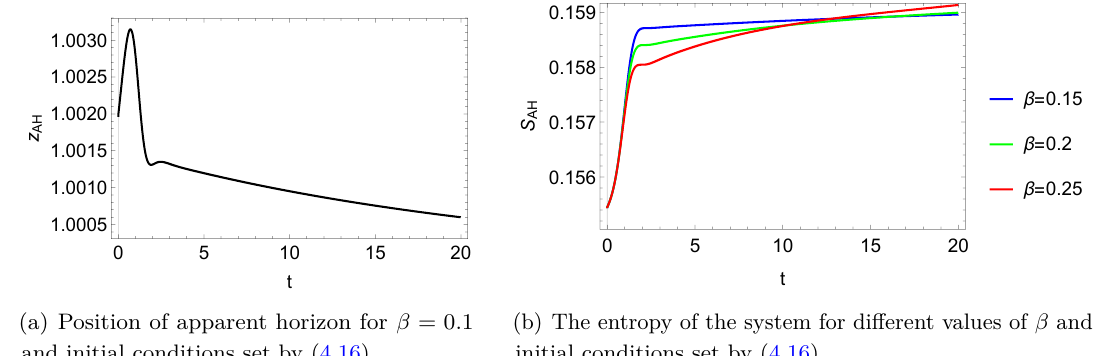
(b) The entropy of the system for different values of β and initial conditions set by (4.16). Figure 14 . The plots of the radial position of the apparent horizon and its area (the entropy of the full system) as a function of time for different values of β and initial conditions set by (4.16). Although the apparent horizon first moves away from the boundary (at z = 0 ) and then towards it, the entropy grows monotonically.